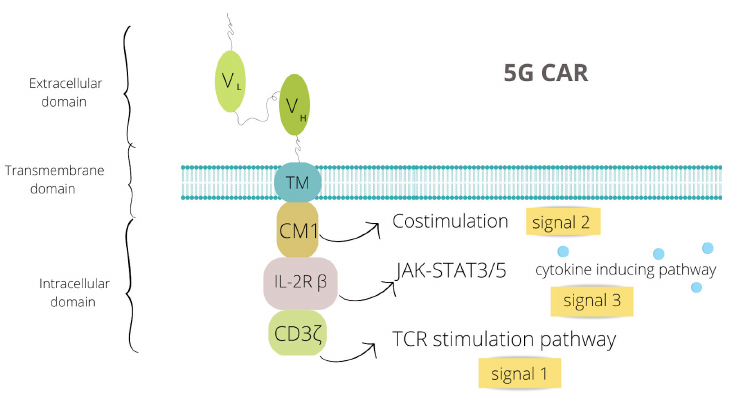
Figure 2. Structure of fifth generation of chimeric antigen receptor (5G CAR), also known as a next generation CAR. VL the light chain variable region, VH the heavy chain variable region, CM1 costimulatory molecule 1, TCR T ‐ cell receptor. Image created with Canva Pro https://www.canva.com/pro/ (accessed on 27 January 2023)